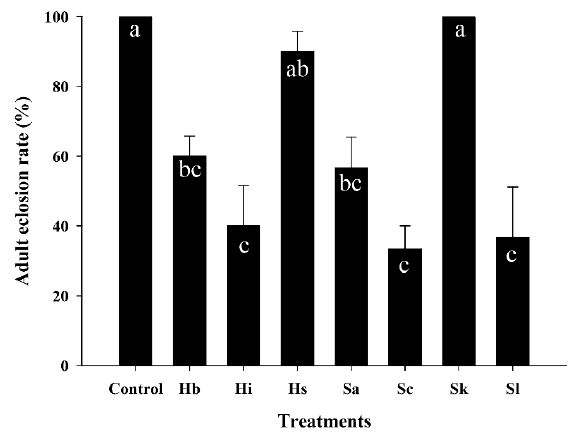
Figure 4. E ff ect of entomopathogenic nematodes (EPNs) on the adult eclosion rate of Spodoptera frugiperda pupae. Pupae ( n = 5 per Petri dish) of S. frugiperda were treated with EPNs (600 infective